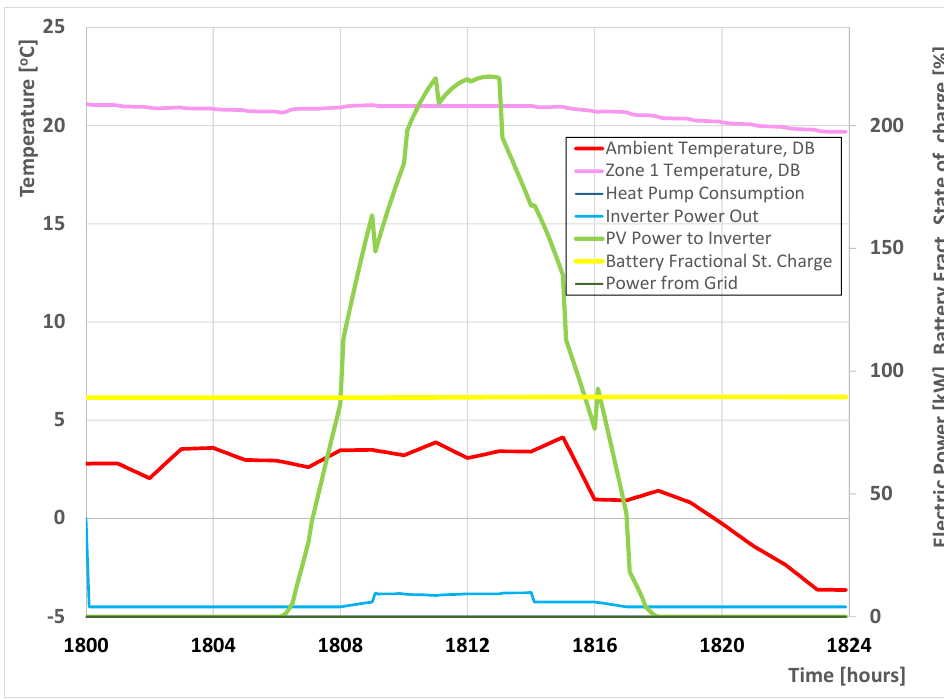
Figure 9. Ambient temperature, room temperature, heat pump electricity consumption, and electric power at the PV inverter outlet, during a cold, sunny weekday of March, starting at midnight.